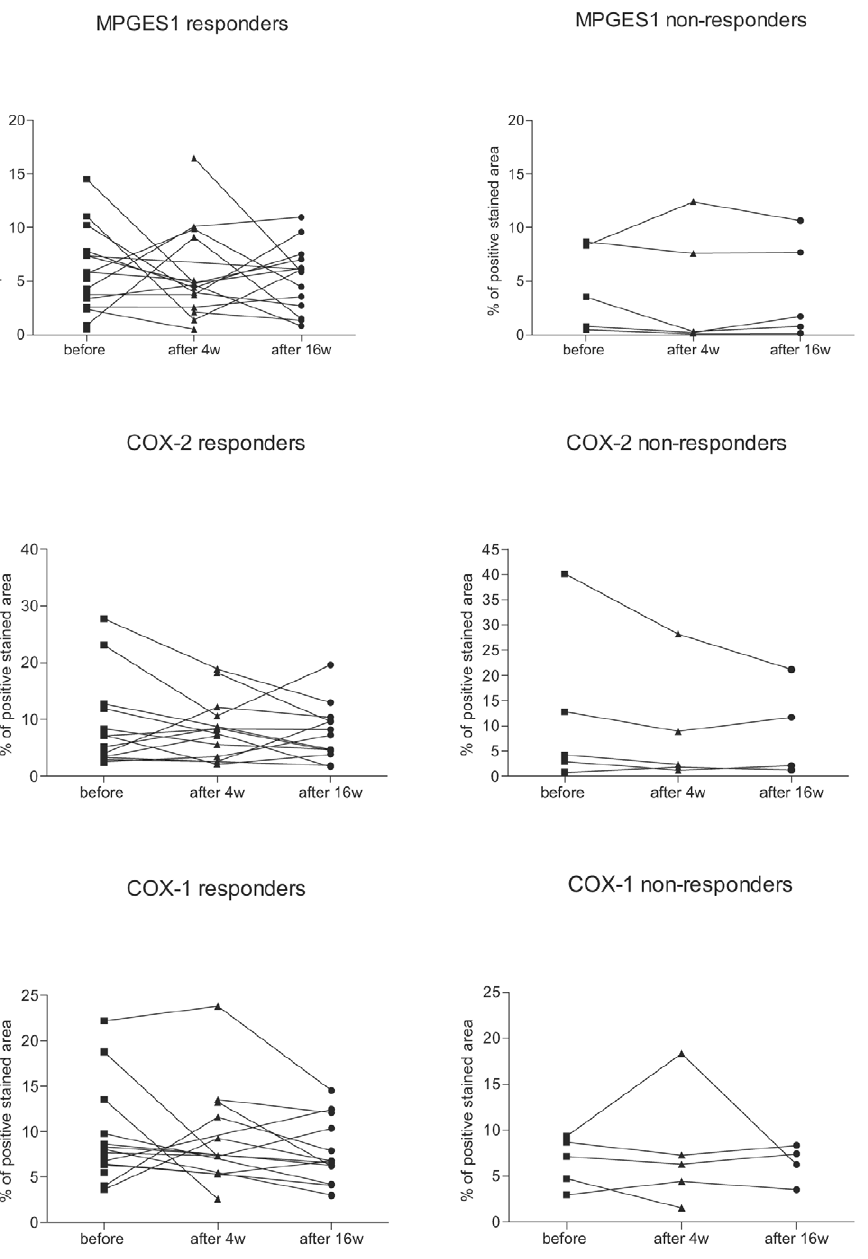
Figure 4. The expression of the PGE 2 biosynthetic enzymes does not differ between responder and non-responder patients. Graphs display immunohistochemical analysis of stained biopsy sections for MPGES1, COX-1 and COX-2 expression in individual responder/non-responder patients at baseline and at 4 weeks and 16 weeks after initiation of rituximab treatment.